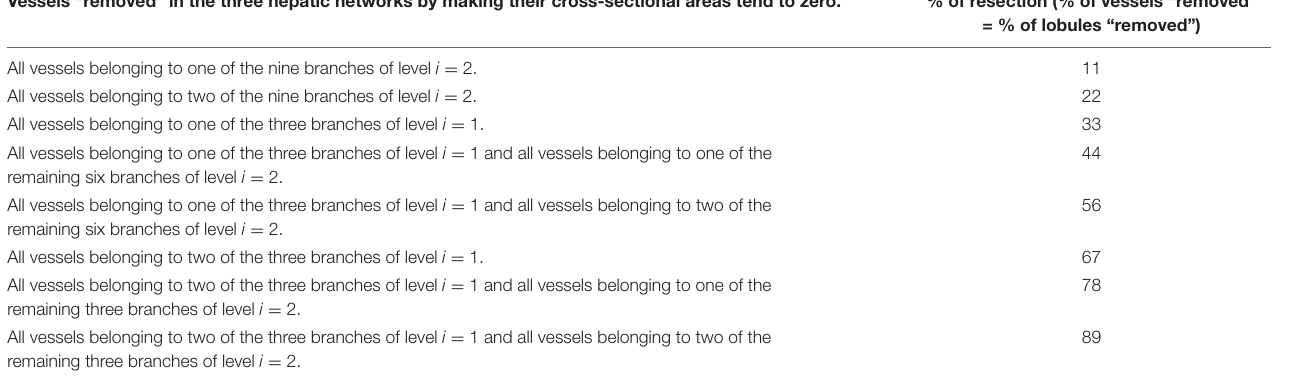
TABLE 4 | Liver resection schemes